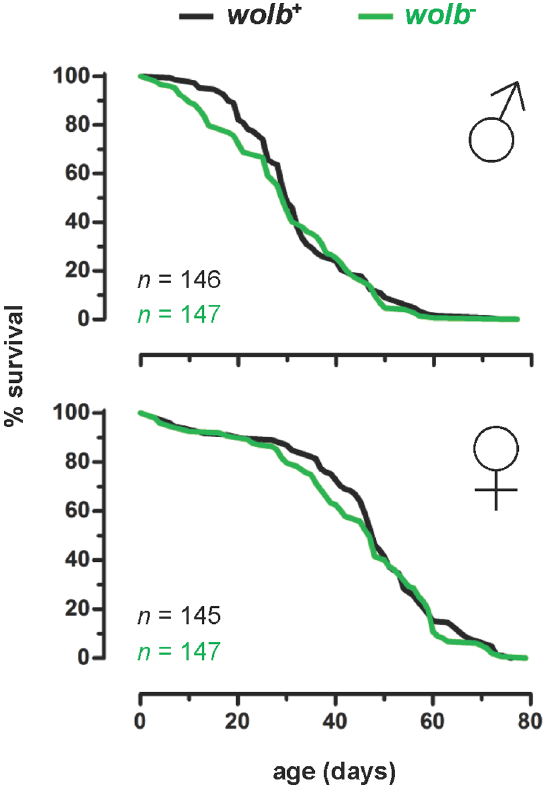
Figure 2. w Flu has no effect on the longevity of adult Ae. fluviatilis . Graphs showing the Kaplan-Meier survival curves for sugar- fed adult males ( = , top graph) and females ( R , bottom graph) of the wildtype ( wolb + ) and antibiotic-treated ( wolb 2 ) strains of the mosquito Ae. fluviatilis . The data shown were pooled from two independent biological replicates (i.e., two different generations of the laboratory colony of Ae. fluviatilis ), and analysed together (see Materials and Methods for details of the experimental design). The survival curves for each sex did not differ significantly between wildtype ( wolb + ) and antibiotic-treated ( wolb 2 ) individuals (log-rank (Mantel-Cox) test: males, x 2 =0.6743, P =0.4116; and females, x 2 =0.5850, P =0.4444; and Mantel- Haenszel hazard ratios: males, ratio=0.9046, 95% CI 0.7121 to 1.1490; and females, ratio=0.9103, 95% CI 0.7154 to 1.1580).